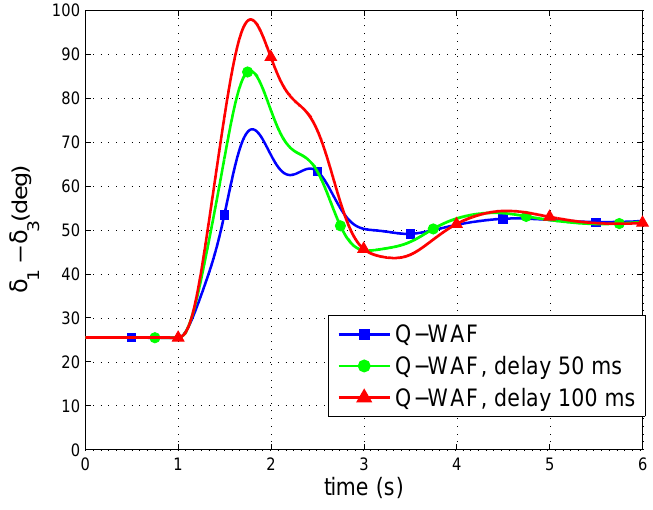
Figure 15. Generator angle